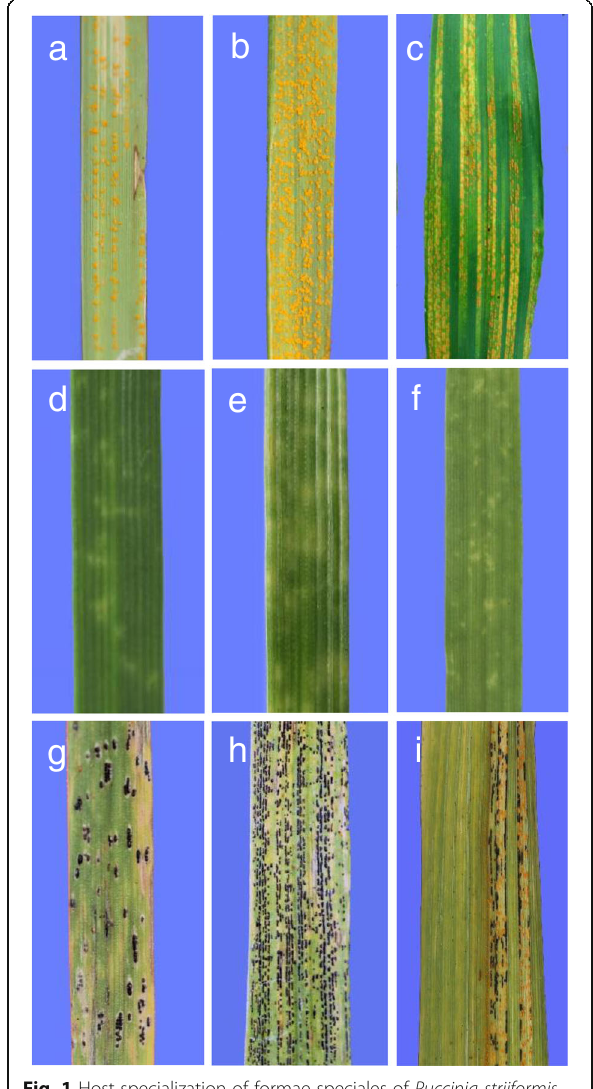
Fig. 1 Host specialization of formae speciales of Puccinia striiformis on their original hosts and wheat and the teliospore formation. a , b , c Uredinial stage of P. striiformis on Agropyron cristatum , Elymus cylindricus , and barley cv. Guoluo ( Hordeum vulgare var. nudum ) . d , e , f Necrotic reaction of P. striiformis f. sp. agropyri , P. striiformis f. sp. elymi , and P. striiformis f. sp. hordei on wheat (cv. Mingxian 169). g , h , i Telial stage of stripe rust on A. cristatum , E. cylindricus , and barley cv. Guoluo . Bar = 50 μ